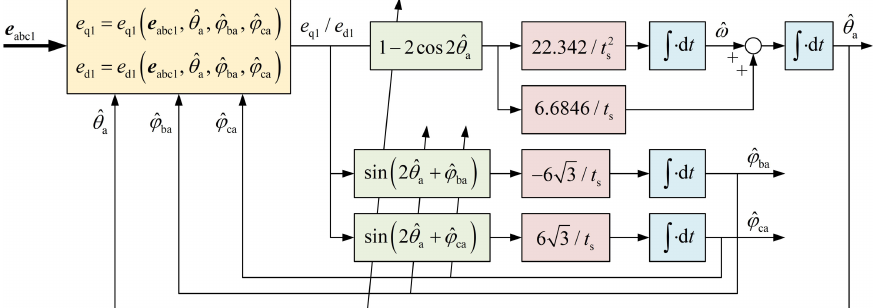
Figure 2. The fundamental components (FC)-detection submodules (DS) structure in detection of fundamental-voltage